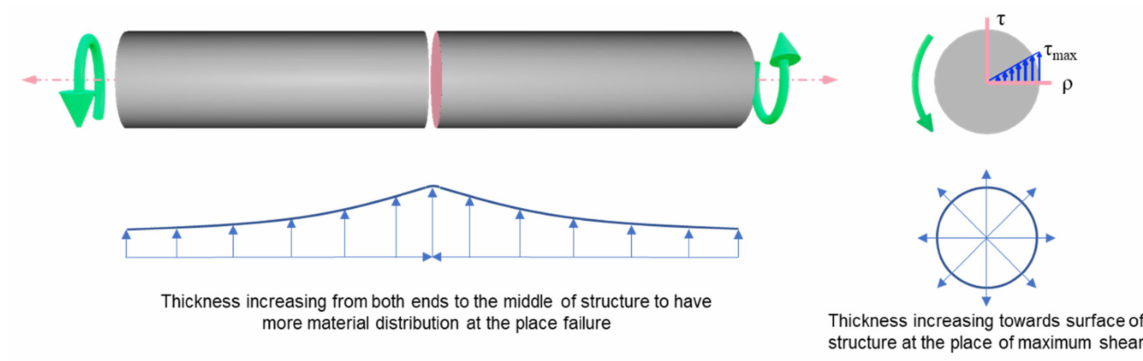
Figure 3. Schematic representation of functionally gradient lattice